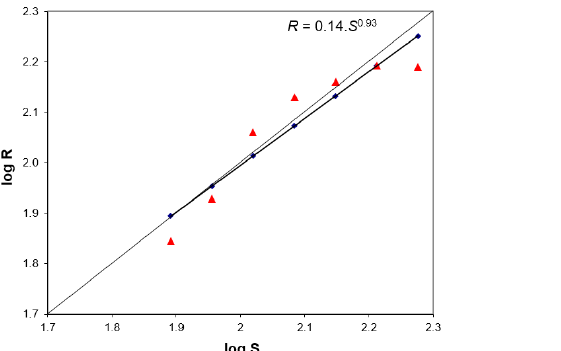
) of a female individual. dif